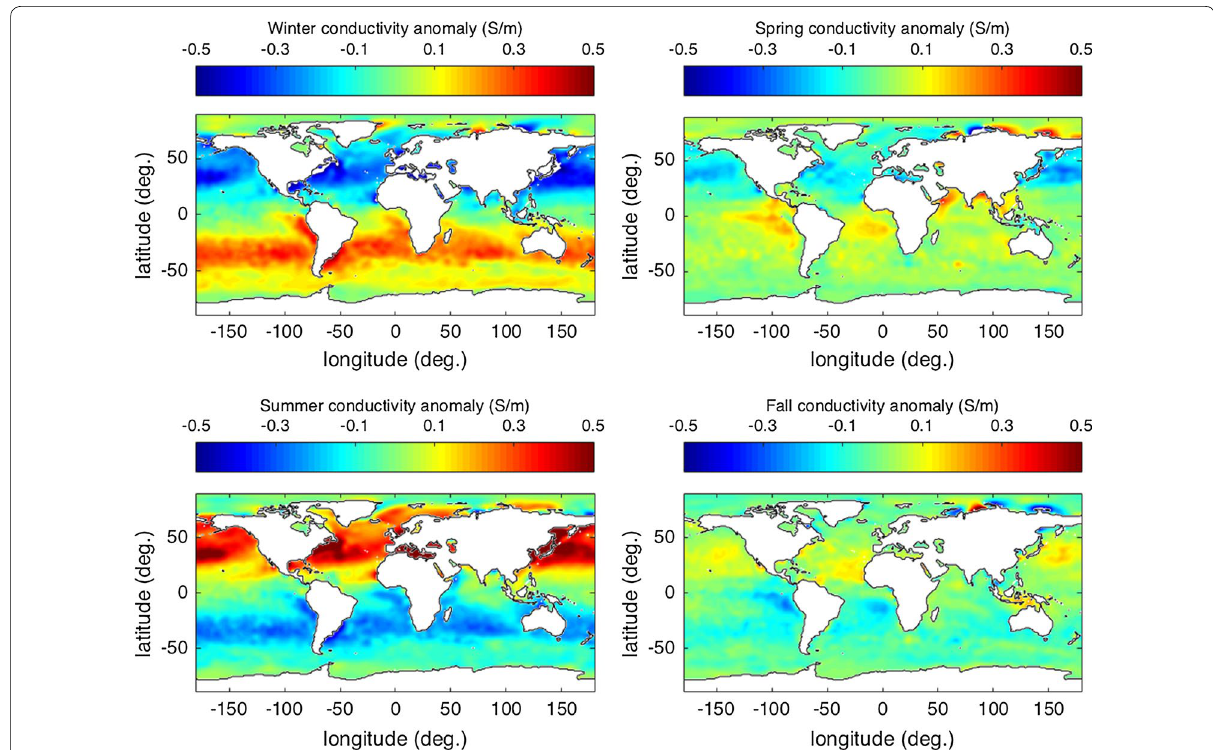
Fig. 5 Ocean surface conductivity anomaly (relative to annual mean) for each of the four seasons. The full range in the data is for Winter, Spring, Summer, and Fall, respectively,